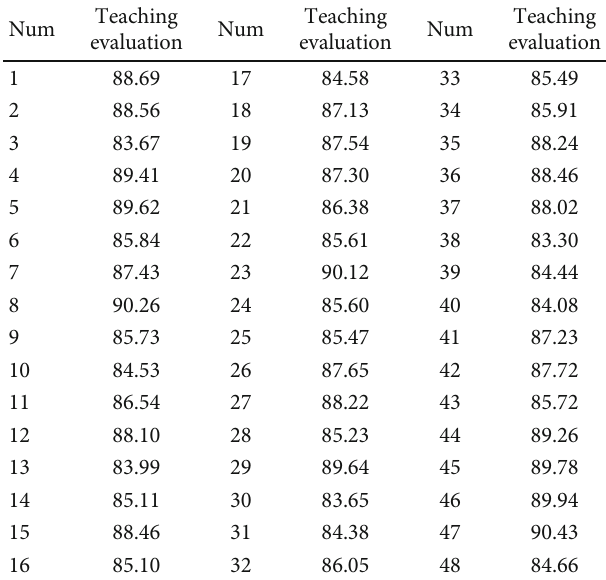
Table 1: Teaching e ff ect evaluation of music classroom teaching system.